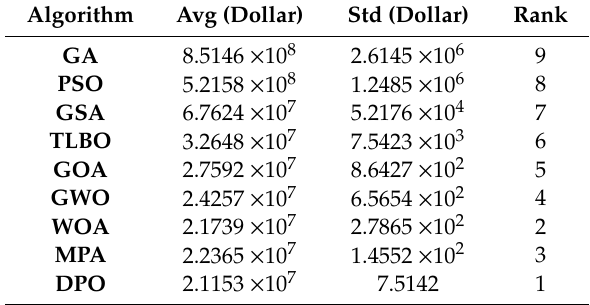
Table 9. Results for DPO and other algorithms in EC